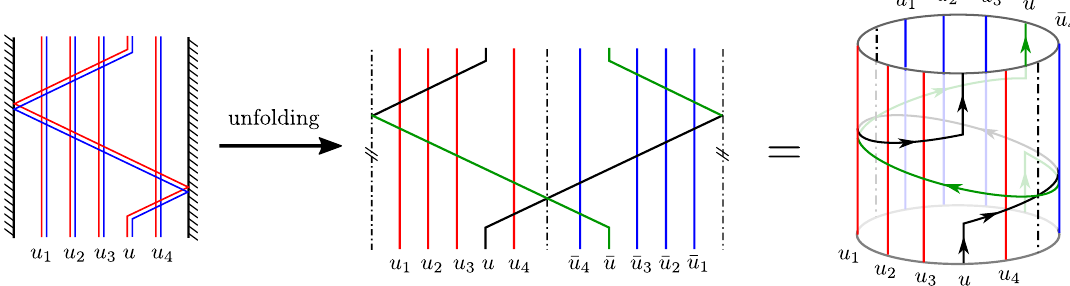
Figure 32 . The unfolding interpretation of the boundary Bethe equation in the mirror